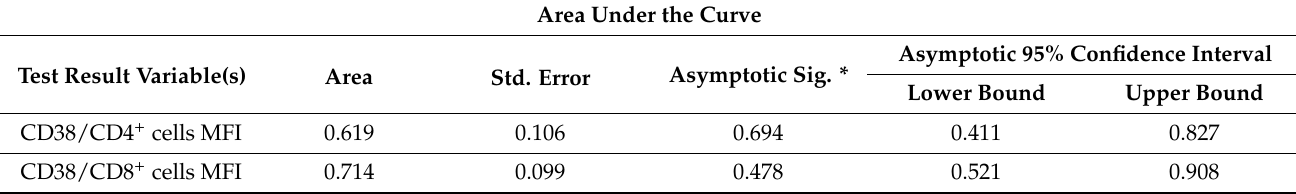
Figure 7. ROC curve of CD38/CD4 + cells and CD38/CD8 + cells to predict mortality among patients of the moderate group. Table 10. ROC analysis of CD38/CD4 + cells and CD38/CD8 + cells to predict mortality among patients of the moderate group. Area Under the